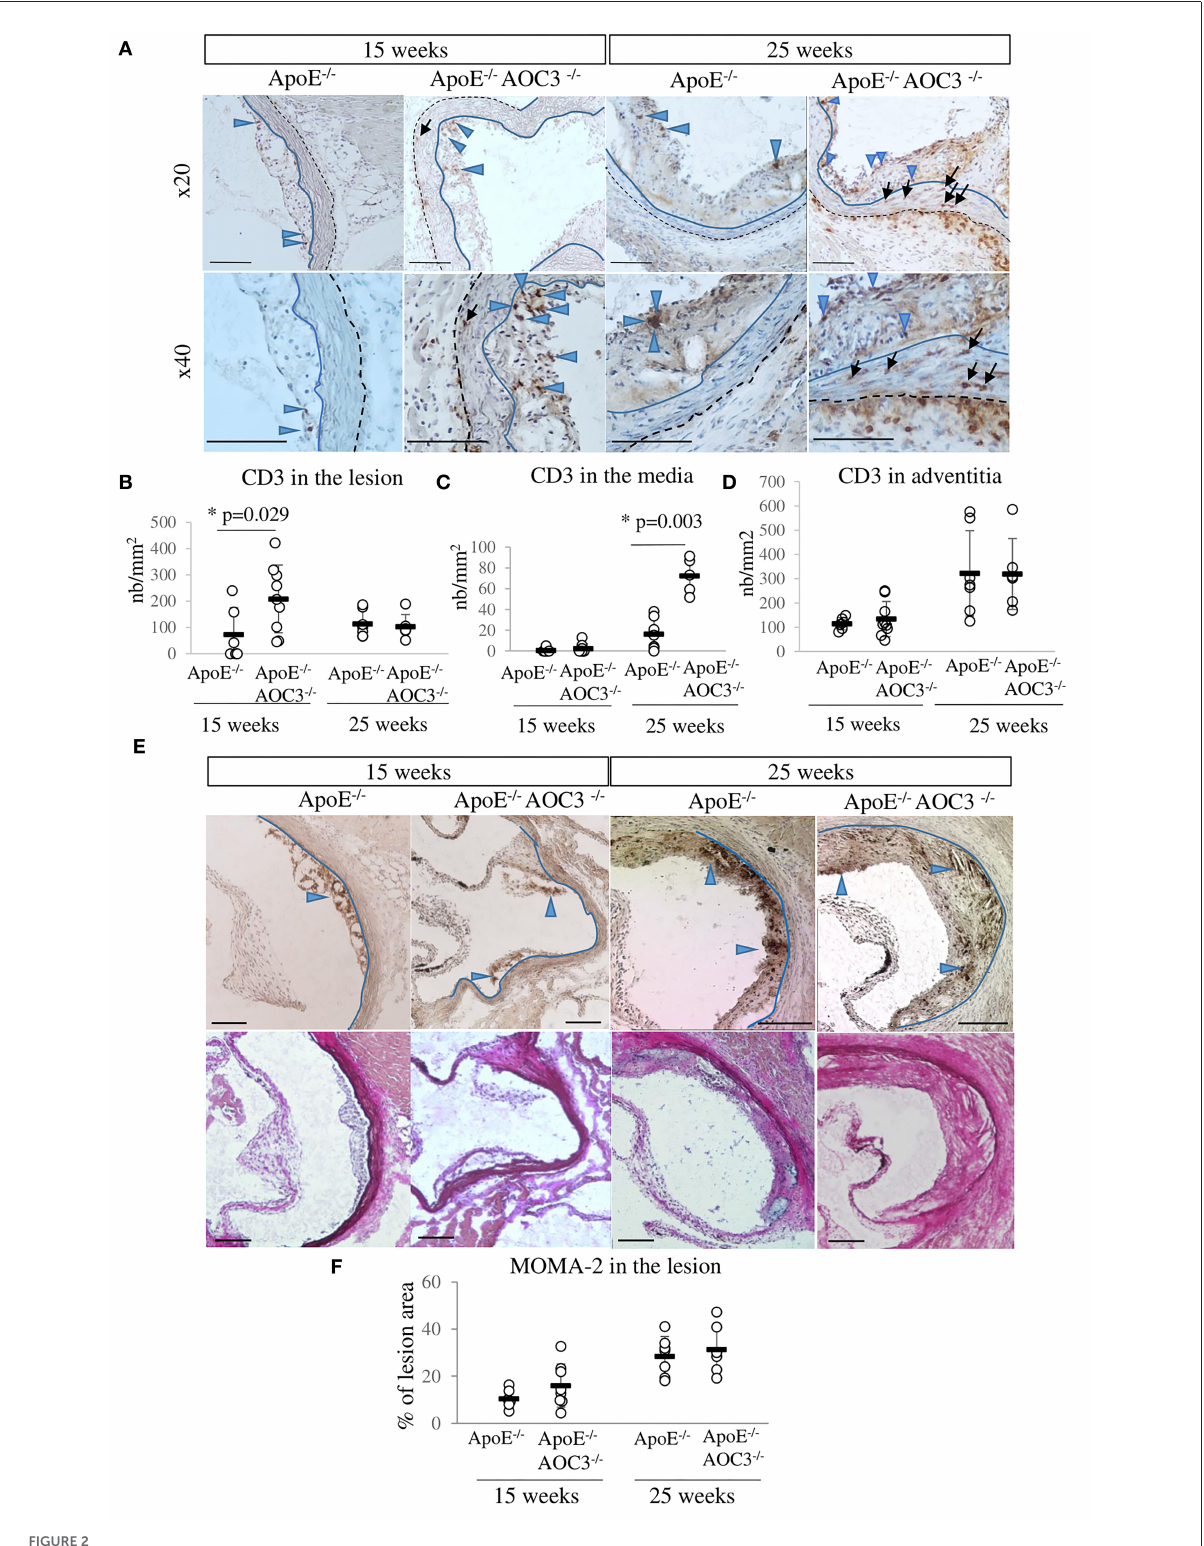
FIGURE2 CD3 + T-cell and macrophage infiltrations in the aortic sinus. CD3 + T-cells and MOMA-2 + macrophages were detected by immunohistochemistry in the aortic sinus of 15- and 25-week-old ApoE − / − and ApoE − / − AOC3 − / − female mice ( n = 6–9). (A)